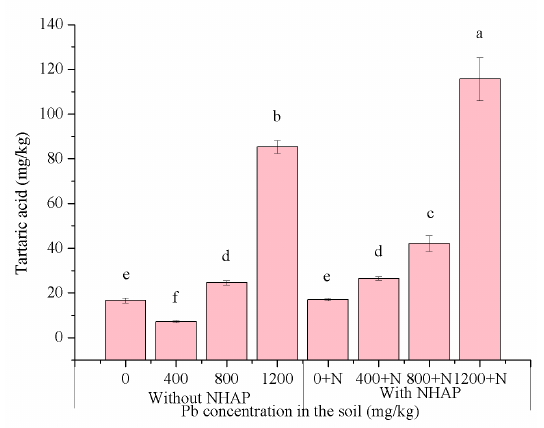
Figure 4. Tartaric acid contents in ryegrass rhizosphere soil under different treatments. a–f: The different letters in the table represent significant differences between treatments at p < 0.05.